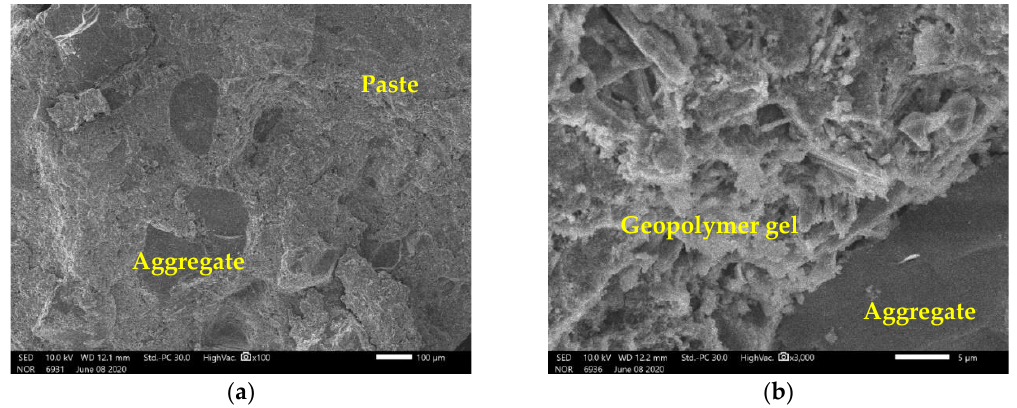
Figure 14. ( a ) Correct bonding between paste and aggregate, interfacial transition zone (ITZ) is not clear; ( b ) at a zoom: ITZ is not clear, geopolymer gel with tabular structure observed.